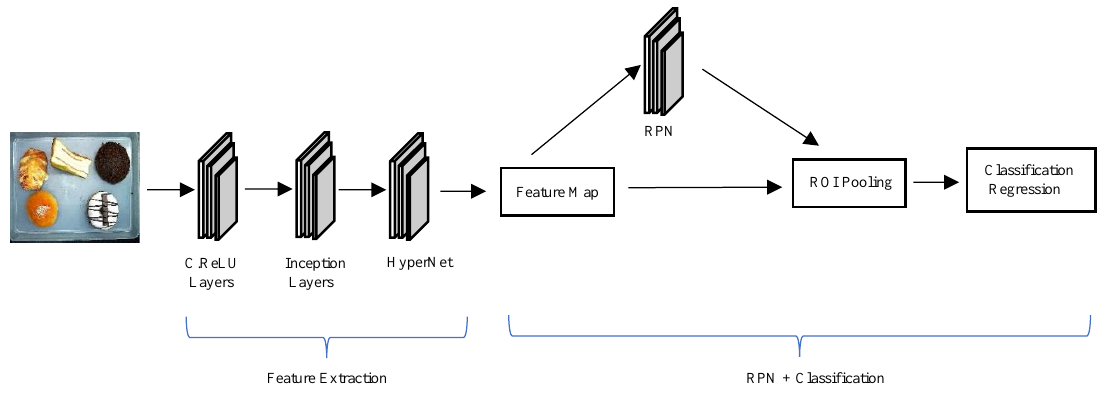
Figure 2. PVA-Net detection